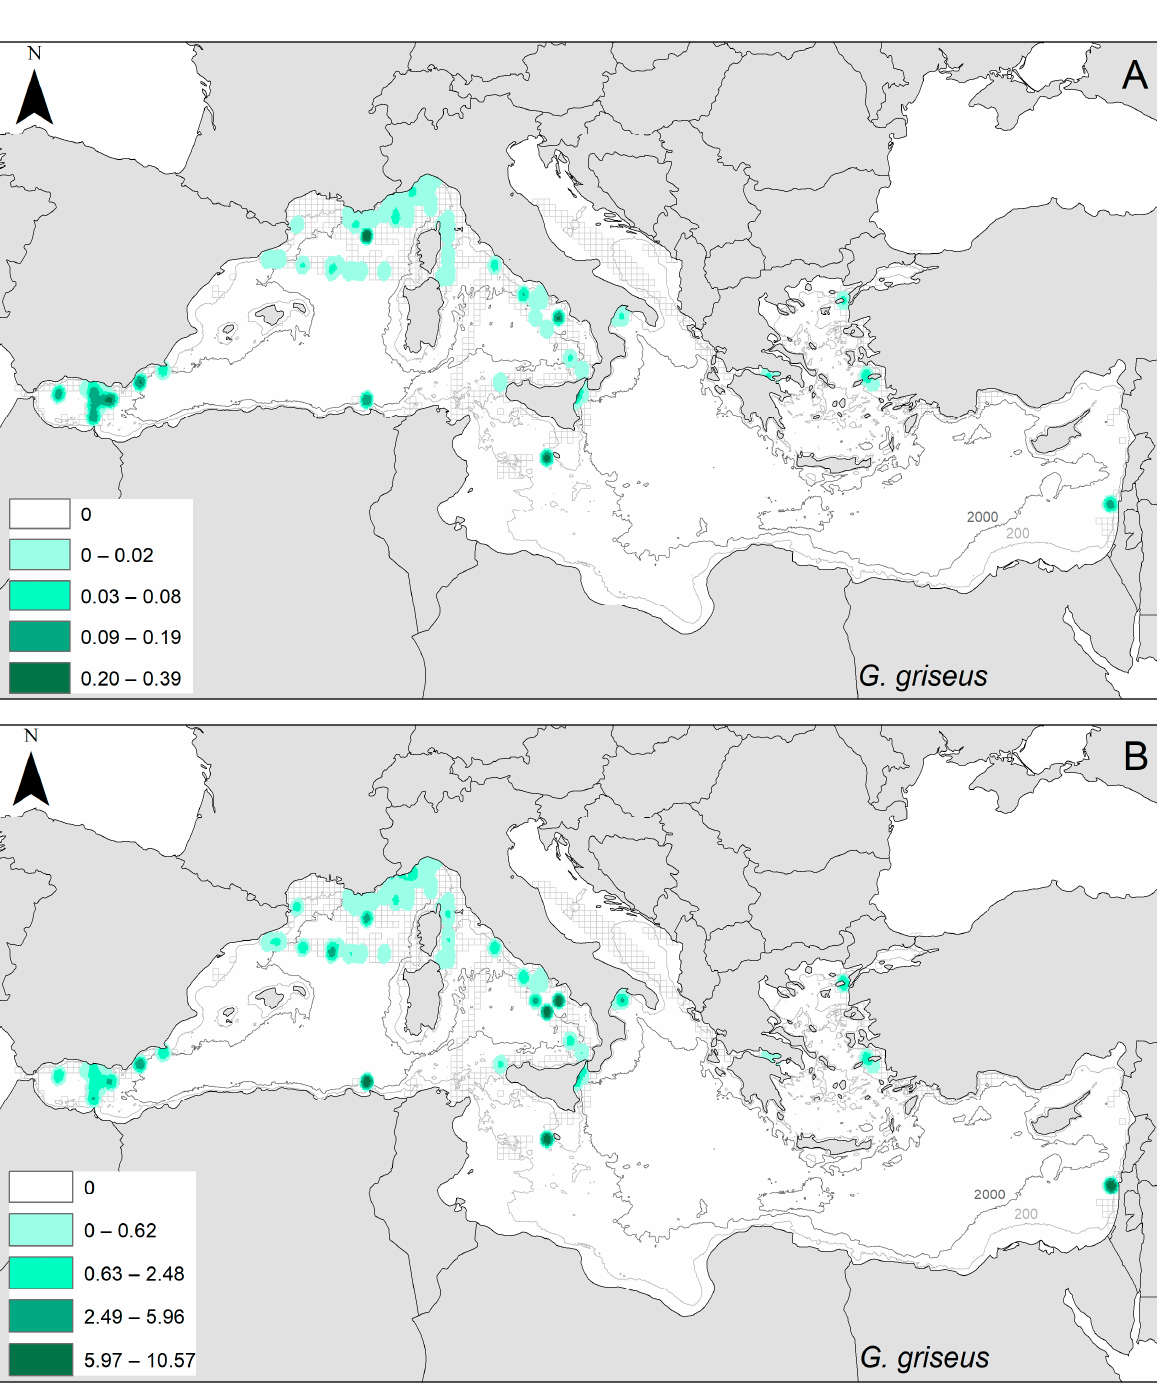
Figure 9. The encounter rate map ( A ) and the prevalence map ( B ) of the Risso’s dolphin ( Grampus griseus ), processed through Kernel density analysis. The Risso’s dolphin was sighted in most of the sampling areas of the west basin, with a scattered distribution. The ER is maximum in the Alboran Sea and lower inside the Mediterranean. The Risso’s dolphin shows a clear preference for the waters outside the continental shelf (>200 m) and a slight preference for the waters of the continental slope (200–2000 m). The prevalence map ( B ) shows the same scattered pattern and, in the Alboran Sea, the prevalence is relatively low (despite the high ER), probably because of the coexistence of other species (Kernel density parameters: cell size x, y = 5 × 5 km; radius ≈ 30 km; criterion for division into classes: natural breaks).